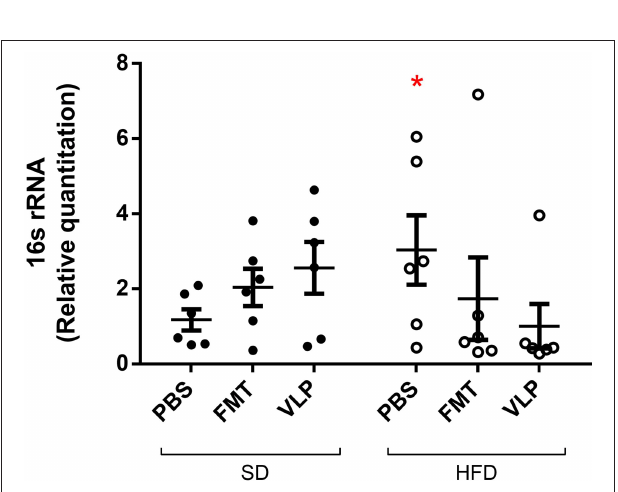
FIGURE 5 | Relative quantitation of the bacterial 16s rRNA gene as a measure of mucosa-associated bacterial density. Data collected by qPCR analysis of extracted DNA from ileum of the small intestine are represented as fold-change relative to the SD-PBS control group and presented as mean ± SEM. Post-hoc analysis of these data using Grubb’s test identified two outliers > 2 standard deviations from the mean ( p < 0.001), one from the HFD-FMT group and one from the HFD-VLP group. Data from these individuals were included in the graph but removed from all analyses (* p <